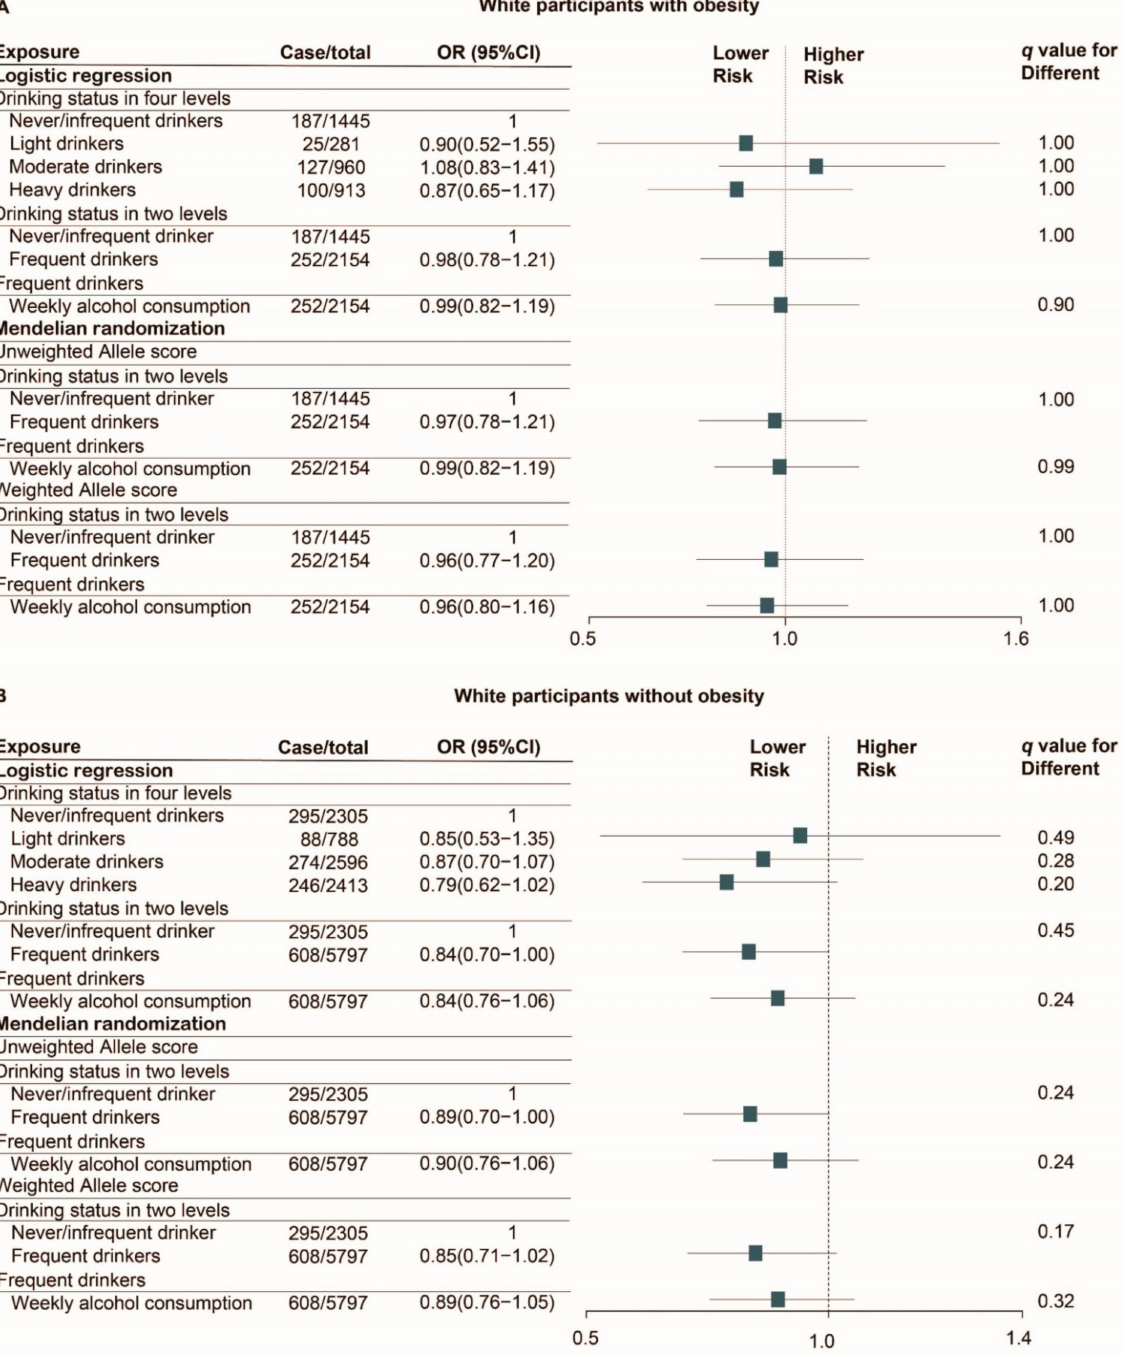
Figure 1. Logistic regression and Mendelian randomization analyses of the association of alcohol consumption with the risk of SARS-CoV-2 infection in white participants with ( A ) and without obesity ( B ). Analyses were performed in PSM cohort (Number of cases was counted from the cohort before PSM). Matching factors for PSM including age, sex, BMI categories, current smoking status, alcohol related diseases, asthma, emphysema, COPD, bronchitis/bronchiectasis, esophagitis, gastritis/duodenitis, peptic ulcer, GERD, hypertensive, chronic ischemic heart disease, heart failure, diabetes, dementia, renal failure, liver cirrhosis and/or liver failure, tumor, and AIDS. q-value was calculated by false discovery rate (FDR) method. Abbreviation: OR, odds ratio; HR, hazard ratio; CI, confidence interval; PSM, propensity score matching; BMI, body mass index; GERD, gastroesophageal reflux disease; COPD, chronic obstructive pulmonary disease; AIDS, acquired immunodeficiency